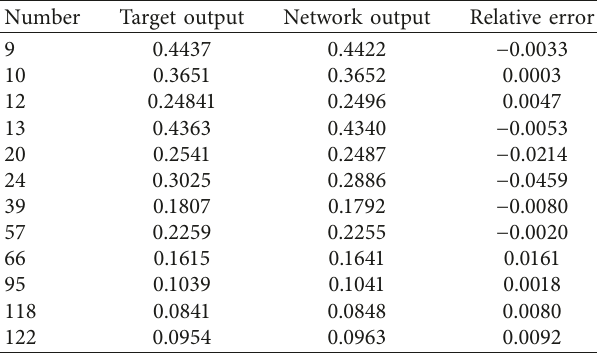
Table 4: Error of the